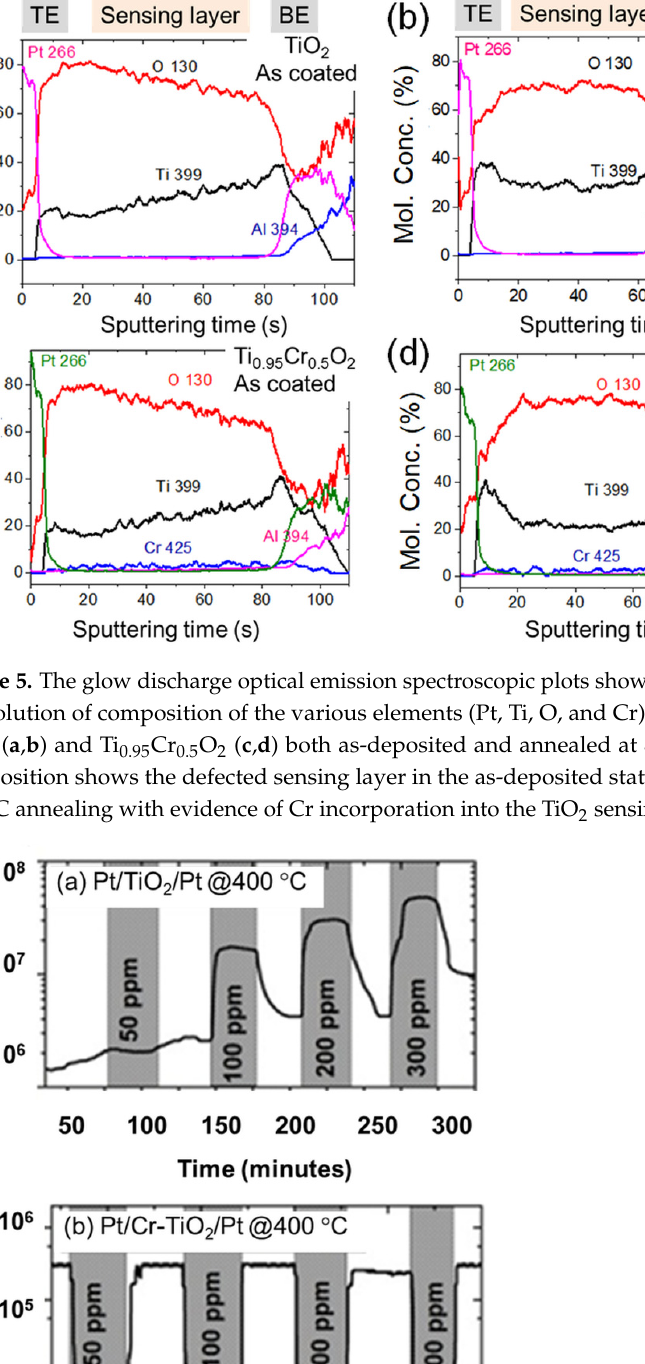
Figure 7. The comparative sensing performance of the Pt/TiO 2 /Pt and Pt/Cr-TiO 2 /Pt ( a ) sensors measured at 400 ° C and annealed at 800 ° C. Further sensing analysis of Pt/Cr-TiO 2 /Pt sensors at various temperatures 100 ° C, 200 ° C, 300 ° C, and 400 ° C ( b ), the dynamic responses of the Pt/Cr- TiO 2 /Pt sensor measured at 200 ° C toward low concentrations (7, 12, 18, 25, 50, 75, and 125 ppm) of